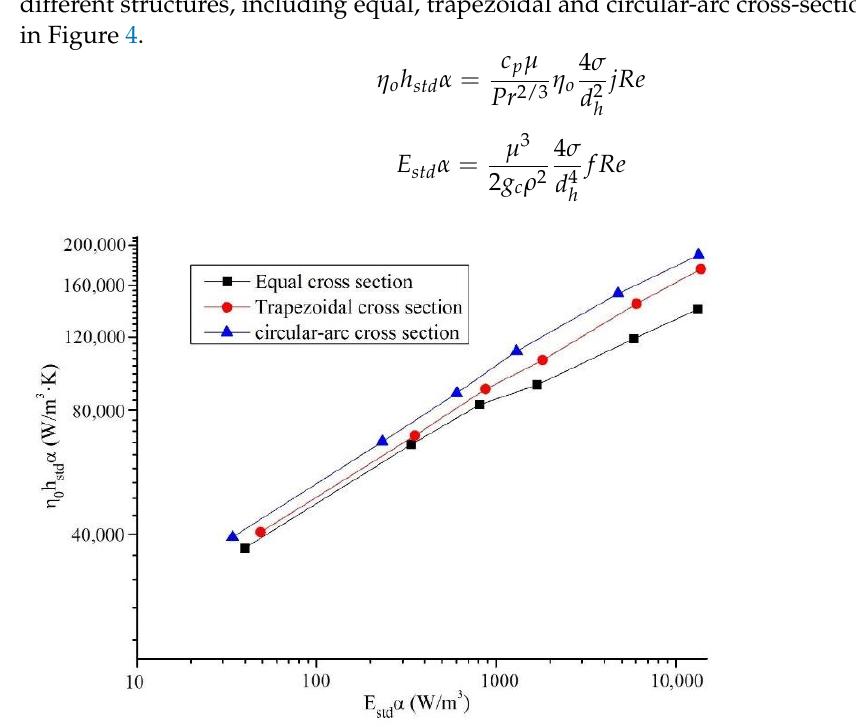
Figure 4. Comparison of core volume goodness factor of three flow channels.